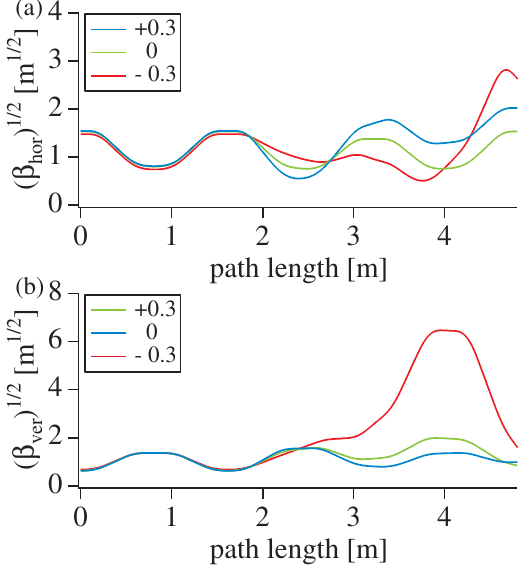
FIG. 9. (Color) Different momentum orbits in a normal cell and the dispersion suppressor. Numbers in the legend show the momentum deviation from the reference momentum, (cid:1) p=p . The normal cell is from 0 to 1.6 m and the dispersion suppressor section from 1.6 to 4.8 m.